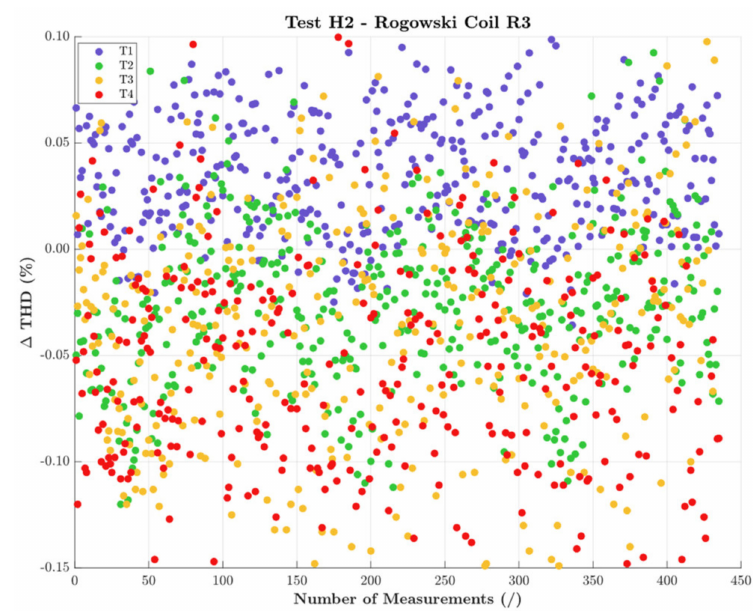
Figure 8. THD variations obtained with H2 and all positions for R3.